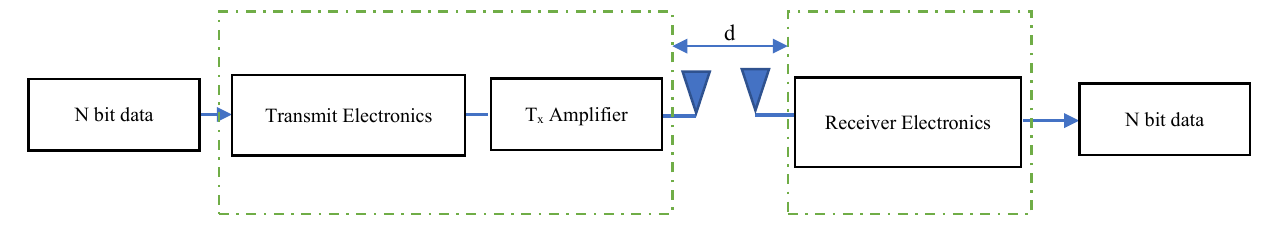
Figure 3. Schematic Diagraph of LEACH Protocol [14]